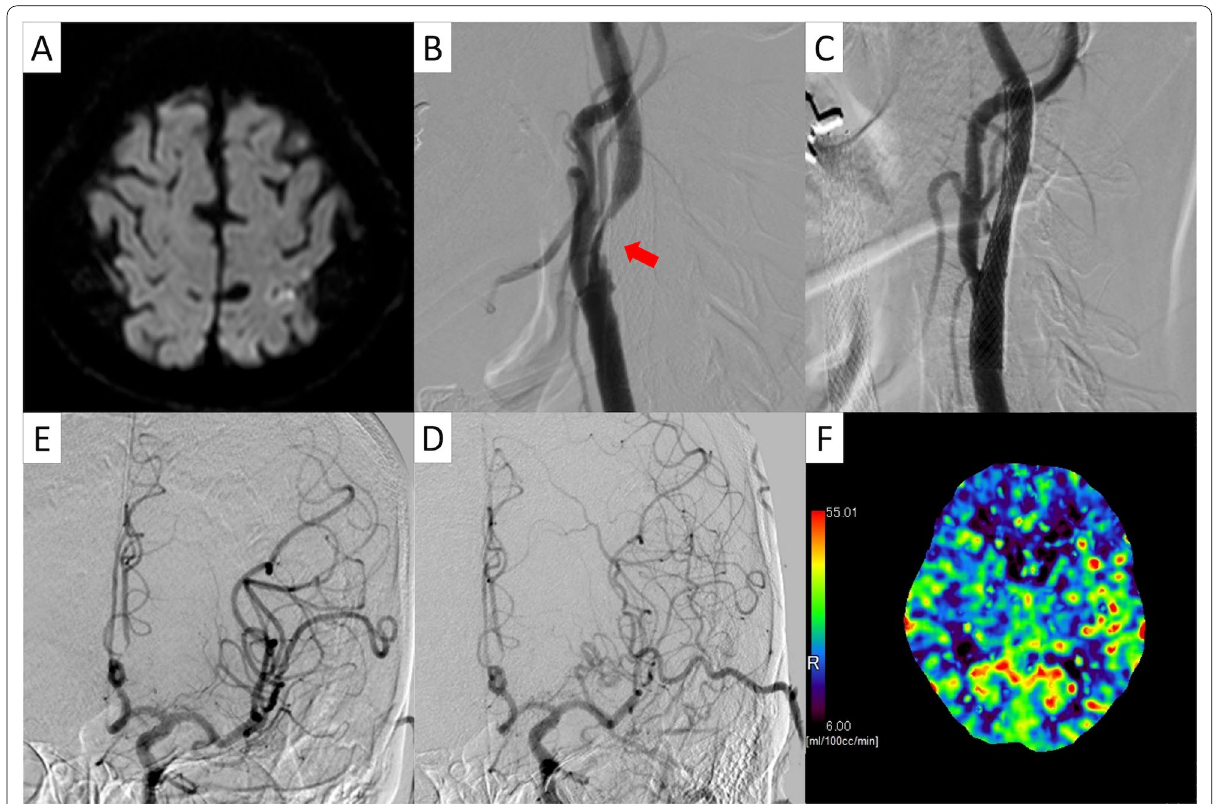
Fig. 1 A Diffusion-weighted imaging performed upon admission revealed multiple cortical cerebral infarctions. B , C Carotid artery stenting was performed for internal carotid artery stenosis (red arrows). D Preoperatively, atherosclerotic stenosis was observed in the left anterior cerebral artery. Digital subtraction angiography (DSA) was performed at the end of the surgery, and the results showed that the left middle cerebral artery (MCA) was dilated. E DSA performed 1 day after the surgery revealed a localized vasoconstriction mainly of the left MCA. F One week after the surgery, CT perfusion revealed hyperperfusion, with a cerebral blood flow contralateral ratio of greater than 1.3. CT perfusion was scanned using a multidetector CT scanner with 80 detector rows (Aquilion Prime, Canon, Japan) and DSA was performed with biplane equipment (Infinix Celeve-i INFX-8000 V, Canon, Japan). MRI scanner was 1.5 T scanner (Magnetom Avanto fit, Siemens Healthcare,